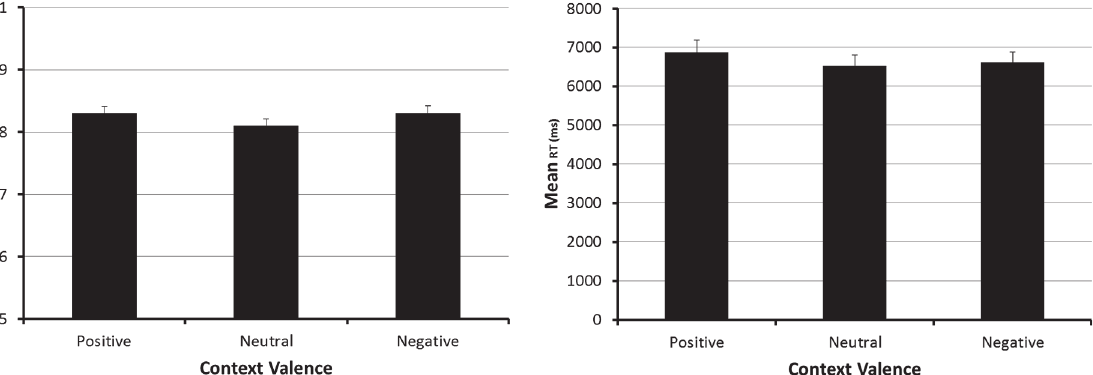
Fig 3. Spot-the-differences task performance in Experiment 1. The figure shows spot-the-differences task accuracy (left panel) and speed (right panel) as a function of the valence of the pictures used for creating the positive, neutral and negative context conditions. The error bars represent the 95% confidence interval for each